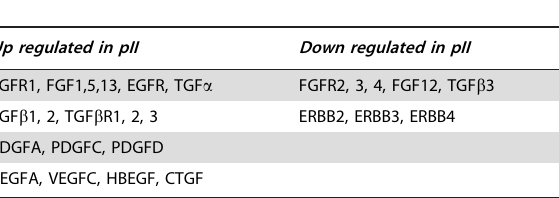
Table 1. Peptide growth factor/receptor genes associated with endocrine resistance.